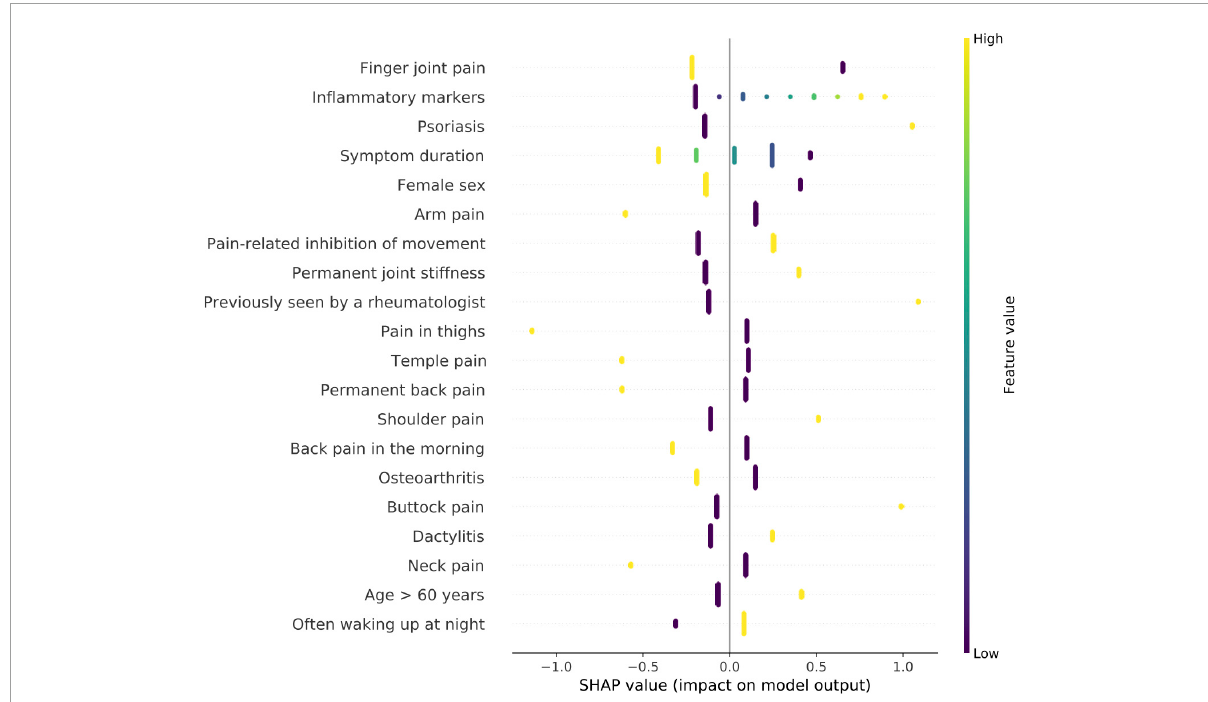
FIGURE3 Feature importance of logistic regression model using SHAP values. High SHAP values (x-axis) represent a high impact on model output. negative values imply impact toward non-IRD classification and positive values direct toward classification as IRD. The y-axis describes the value levels; low representing 0 and negative